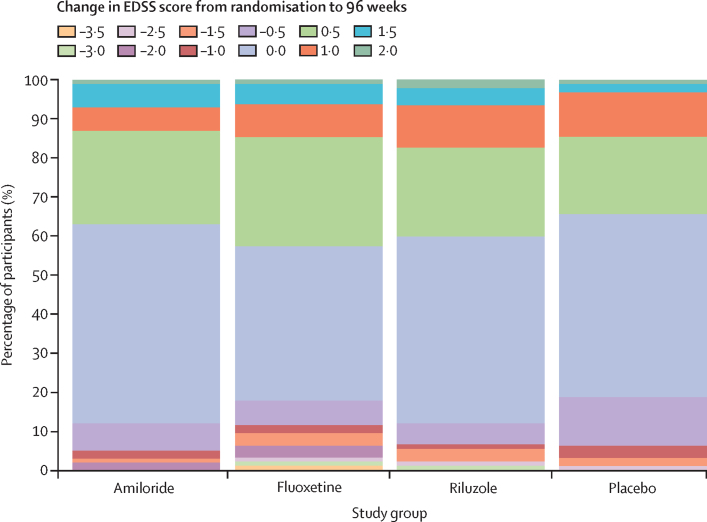
Stacked bar chart for change in EDSS score from randomisation to 96 weeksPositive change is worsening in EDSS score and negative change is improvement in EDSS score. EDSS=Expanded Disability Status Scale.